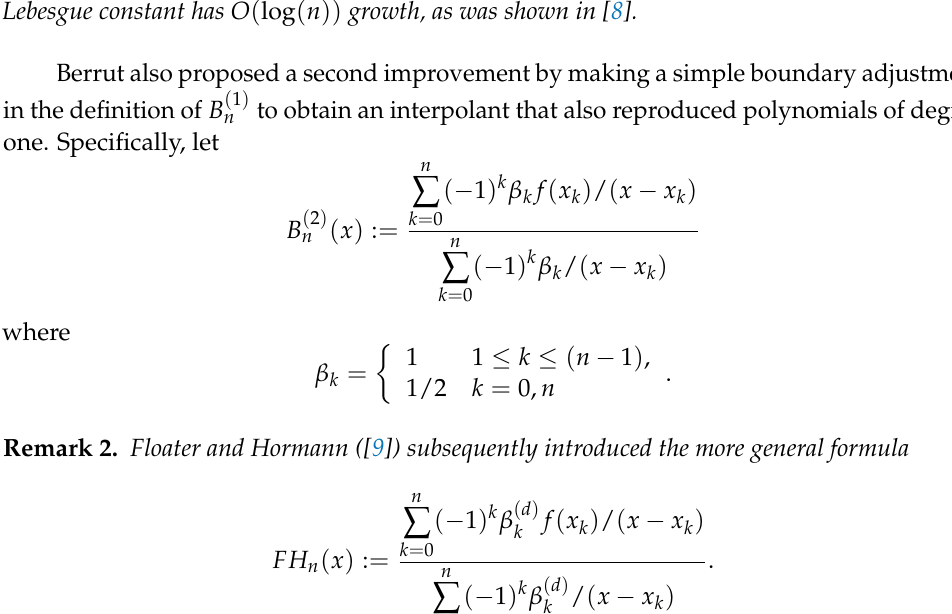
( 1 ) ( x ) = x 2 and n = 11 and n = n for f